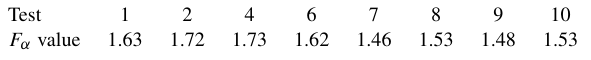
Table 1. F α values for eight calibration tests made on the same wind turbine. Tests 7 to 10 were made with exact same rotor posi- tion relative to a wind turbine yawing span of ± 60 ◦ .